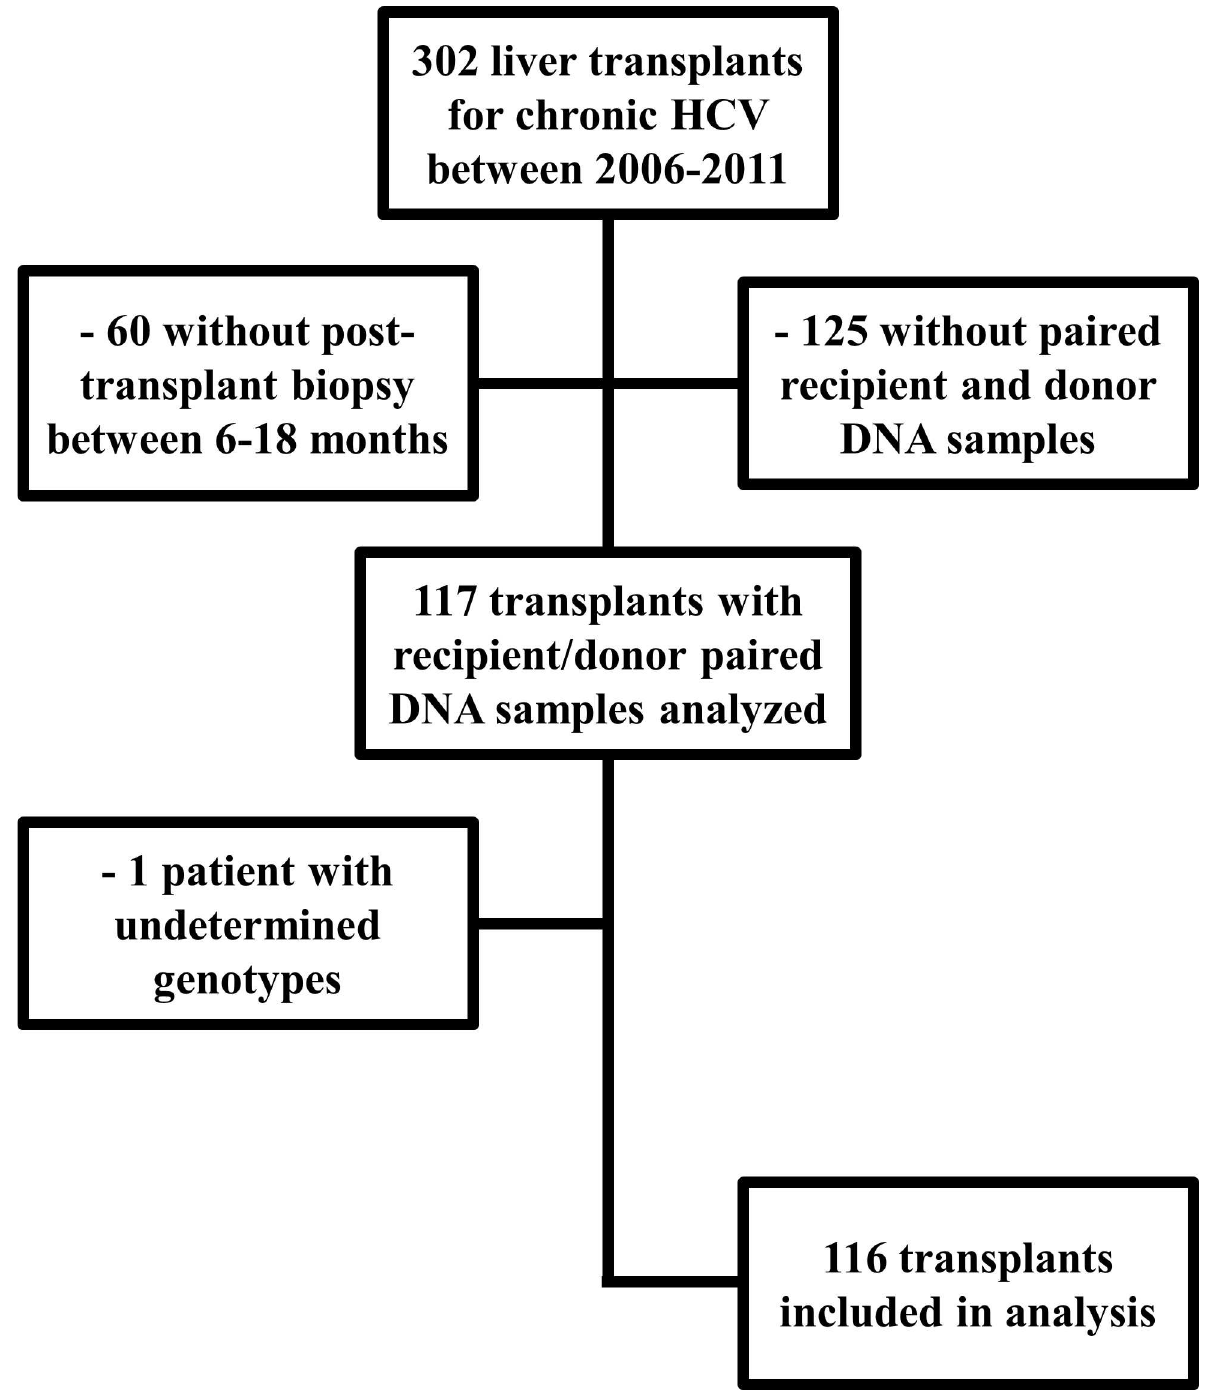
Fig 1. Identification of Patient Population.